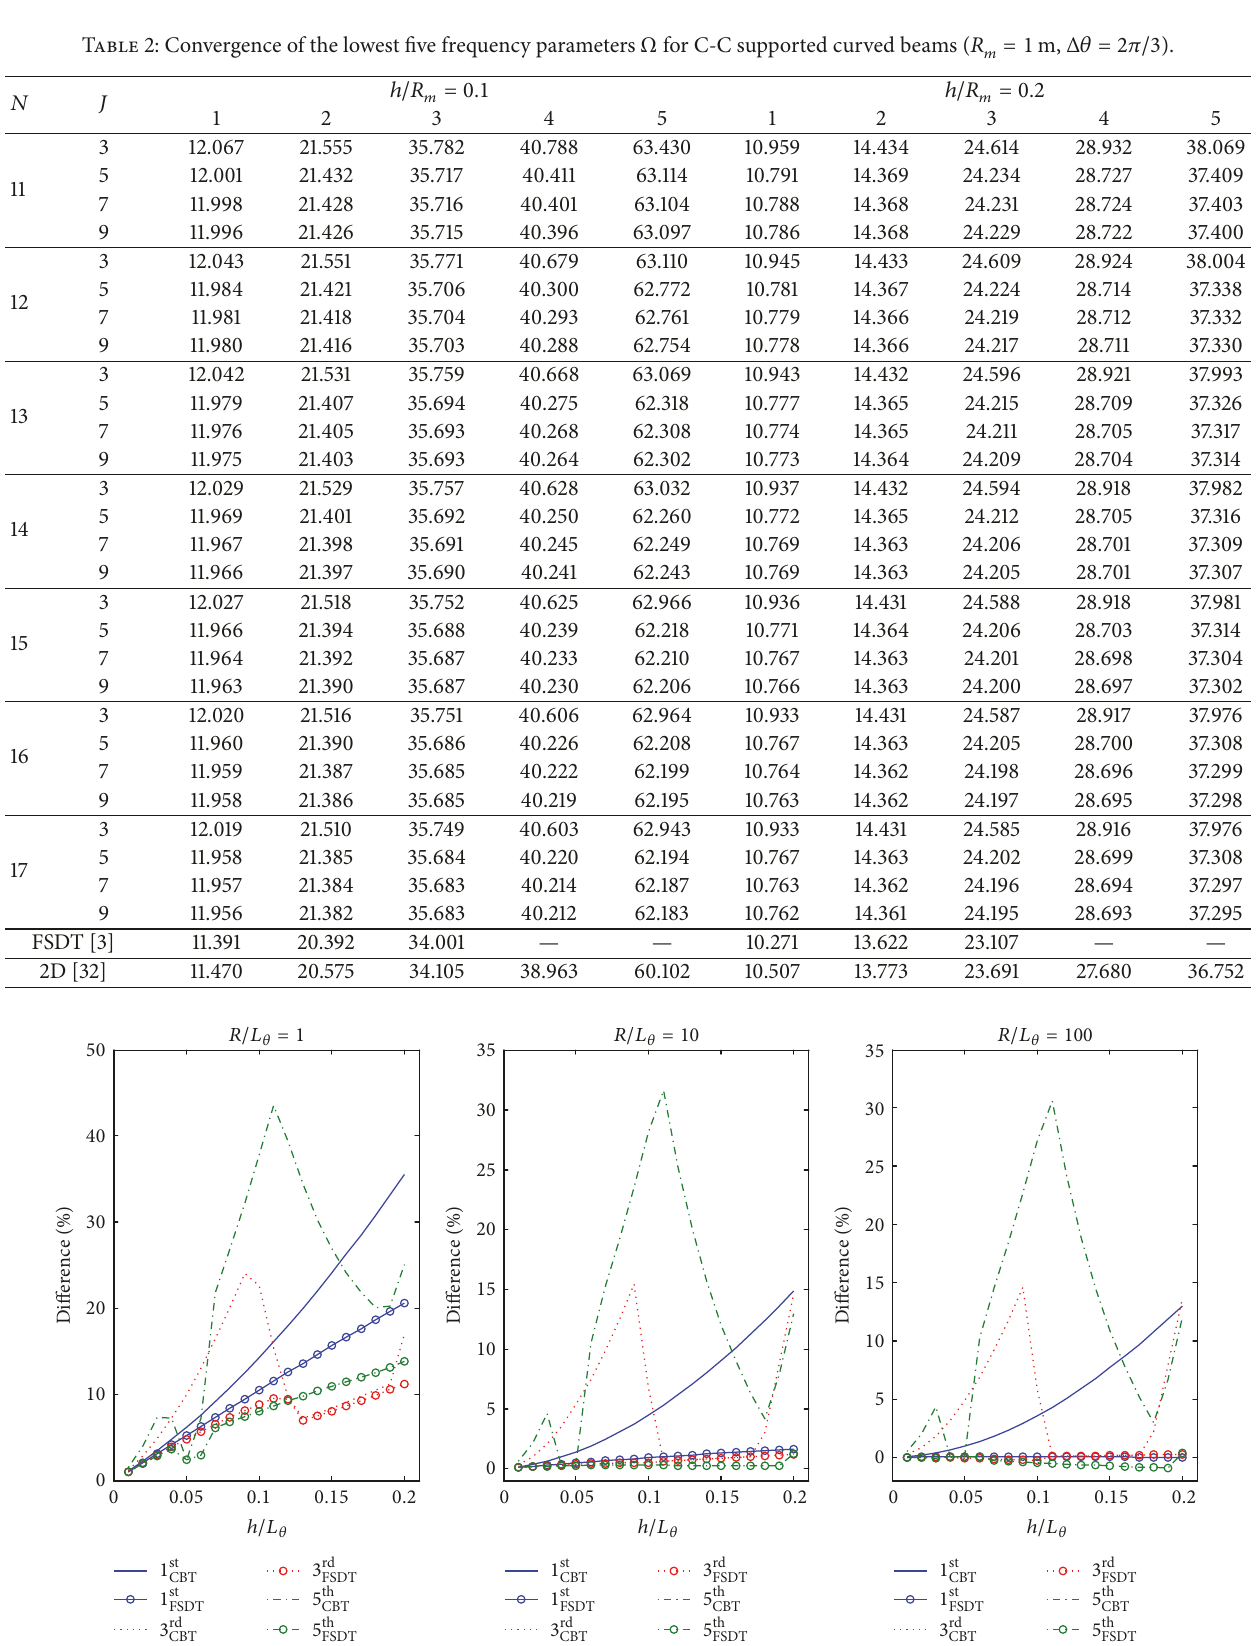
Figure 2: Relative deviations between the first, third, and fifth frequency parameters Ω based on the CBT/FSDT theory models to those of 2D theory for a complete free circular beam with various thickness